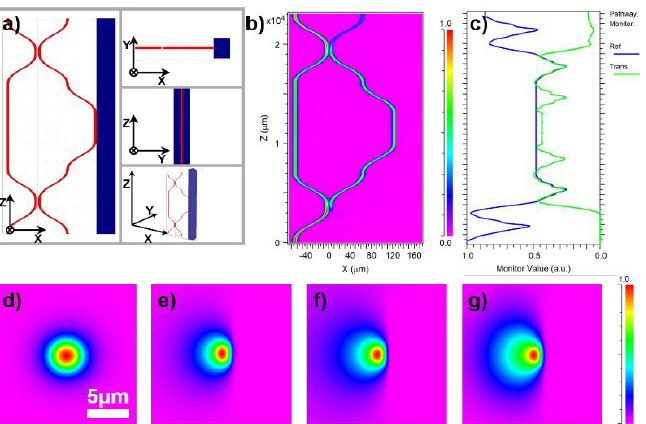
Figure 2. ( a ) Three views (x − z, y − z, x − y) and a 3D view of MZ interferometer in Rsoft CAD. ( b ) The energy distribution of 808 nm light propagating in an MZ interferometer. ( c ) The normalized energy evolution of the reference arm (blue line) and the sensing arm (green line). ( d ) The fundamental mode field distribution. ( e , f ) The mode field distribution in the sensing arm immersed in water and glycerol when the polishing depth is 33%. ( g ) The radiation mode in the sensing arm immersed in glycerol when the polishing depth is 45%.